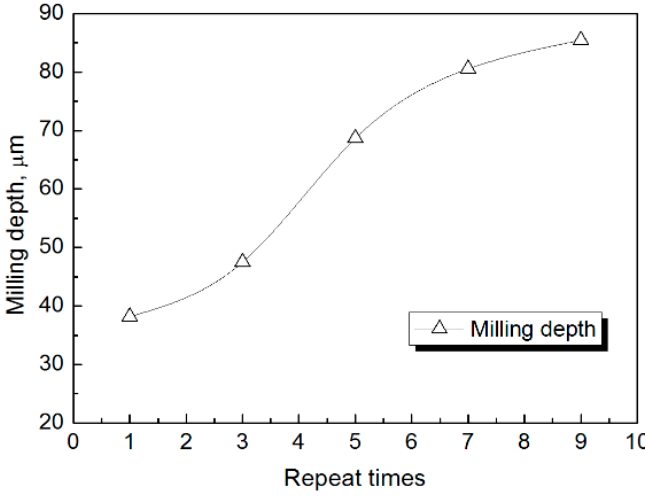
Figure 10. Milling depth after different numbers of milling operations.